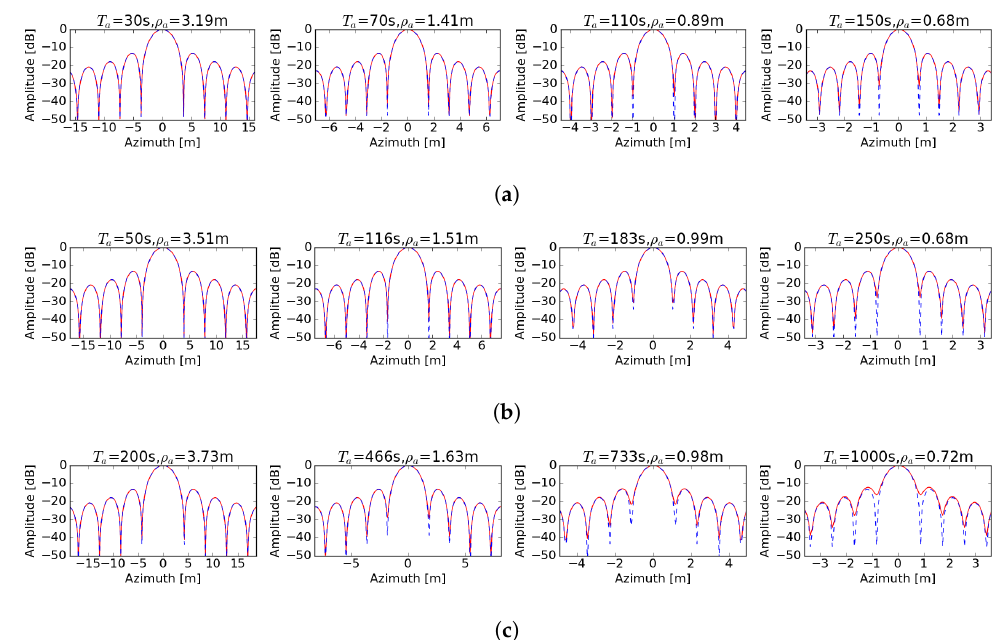
Figure 6. Influences of the spatially variant error of BTD on the azimuth impulse response under different integration times in the X band ( a ), C band ( b ), and L band ( c ) cases. The blue dotted line represents the ideal result, and the red solid line represents the influenced result.